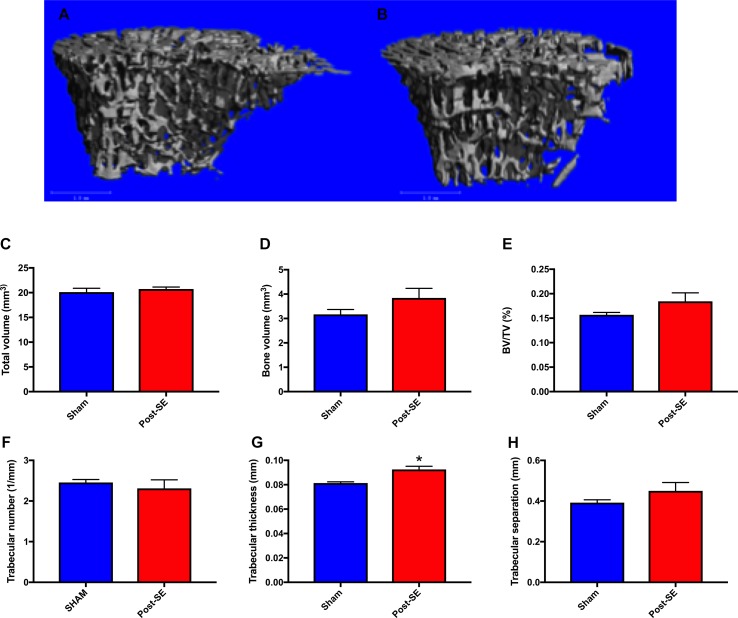
Representative μCT reconstructions of trabecular bone regions from sham (A) and Post-SE rats (B). There were no differences between post-SE rats when compared to shams on the measures of total volume (C), bone volume (D), bone volume fraction (E), trabecular number (F) or trabecular separation (H). However, trabecular thickness (G) was significantly increased in post-SE rats when compared to shams. Bars represent means ± SEM and * represents p < 0.05.